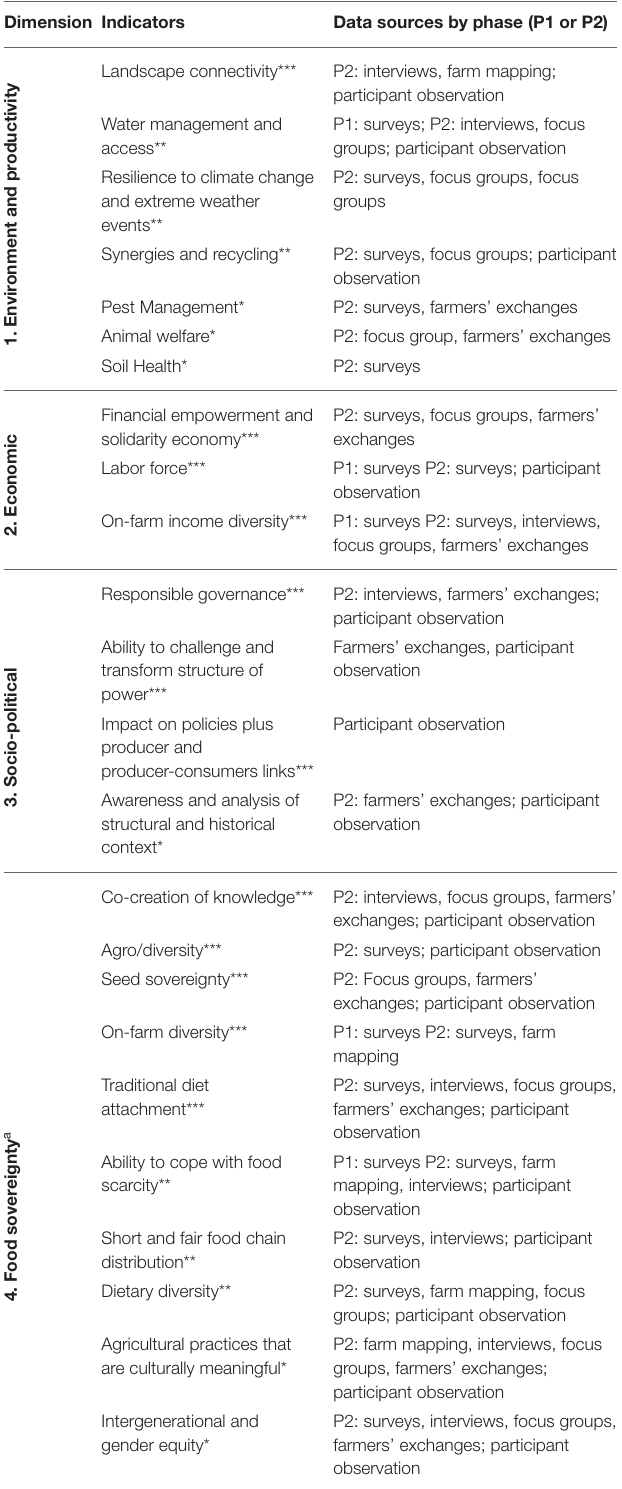
TABLE 1 | Dimensions and indicators of transformative agroecology in coffee socio-ecological systems. Dimension Indicators Data sources by phase (P1 or